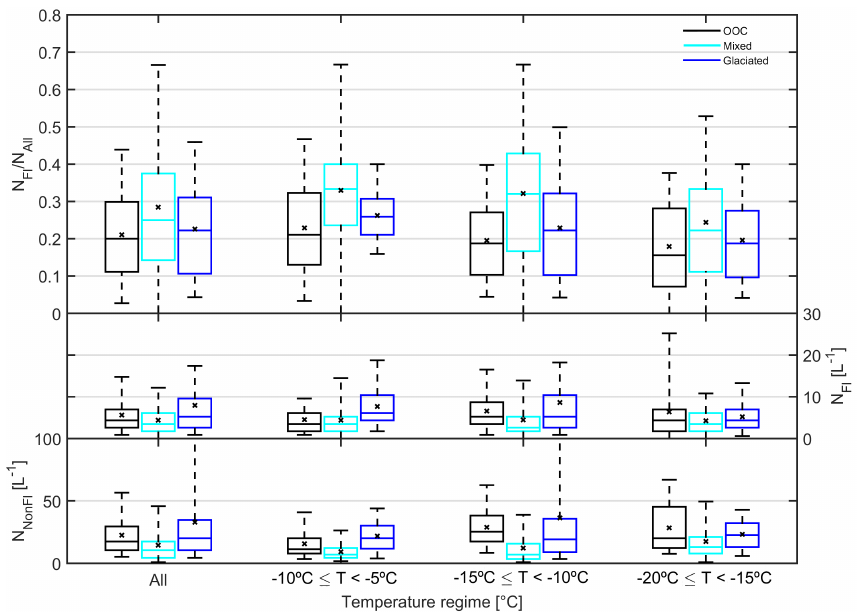
Figure 6. Top panel: fluorescent to total aerosol concentration ratio for out-of-cloud (black, TWC < 0.01gm − 3 ), mixed-phase (cyan, TWC ≥ 0.01gm − 3 and IMF < 0.9), and glaciated (blue, TWC ≥ 0.01gm − 3 and IMF ≥ 0.9) conditions sampled with the total inlet. Middle and bottom panels: total fluorescent, N F , and total non-fluorescent, N NonFl , aerosol concentrations. Box and whiskers denote 5th, 25th, 50th, 75th, and 95th percentiles; x marker denotes mean.